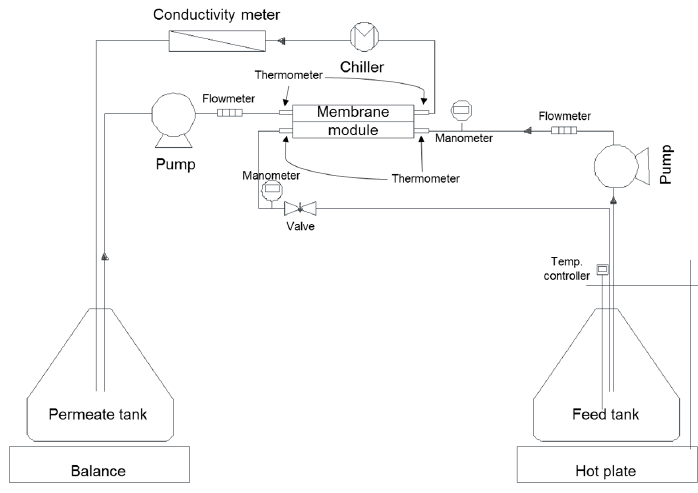
Figure 4. Schematic diagram of DCMD experiment set-up.